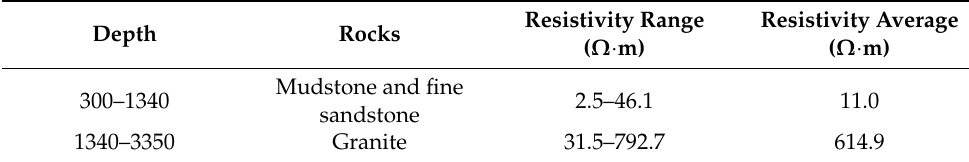
Table 1. Logging resistivity characteristics of